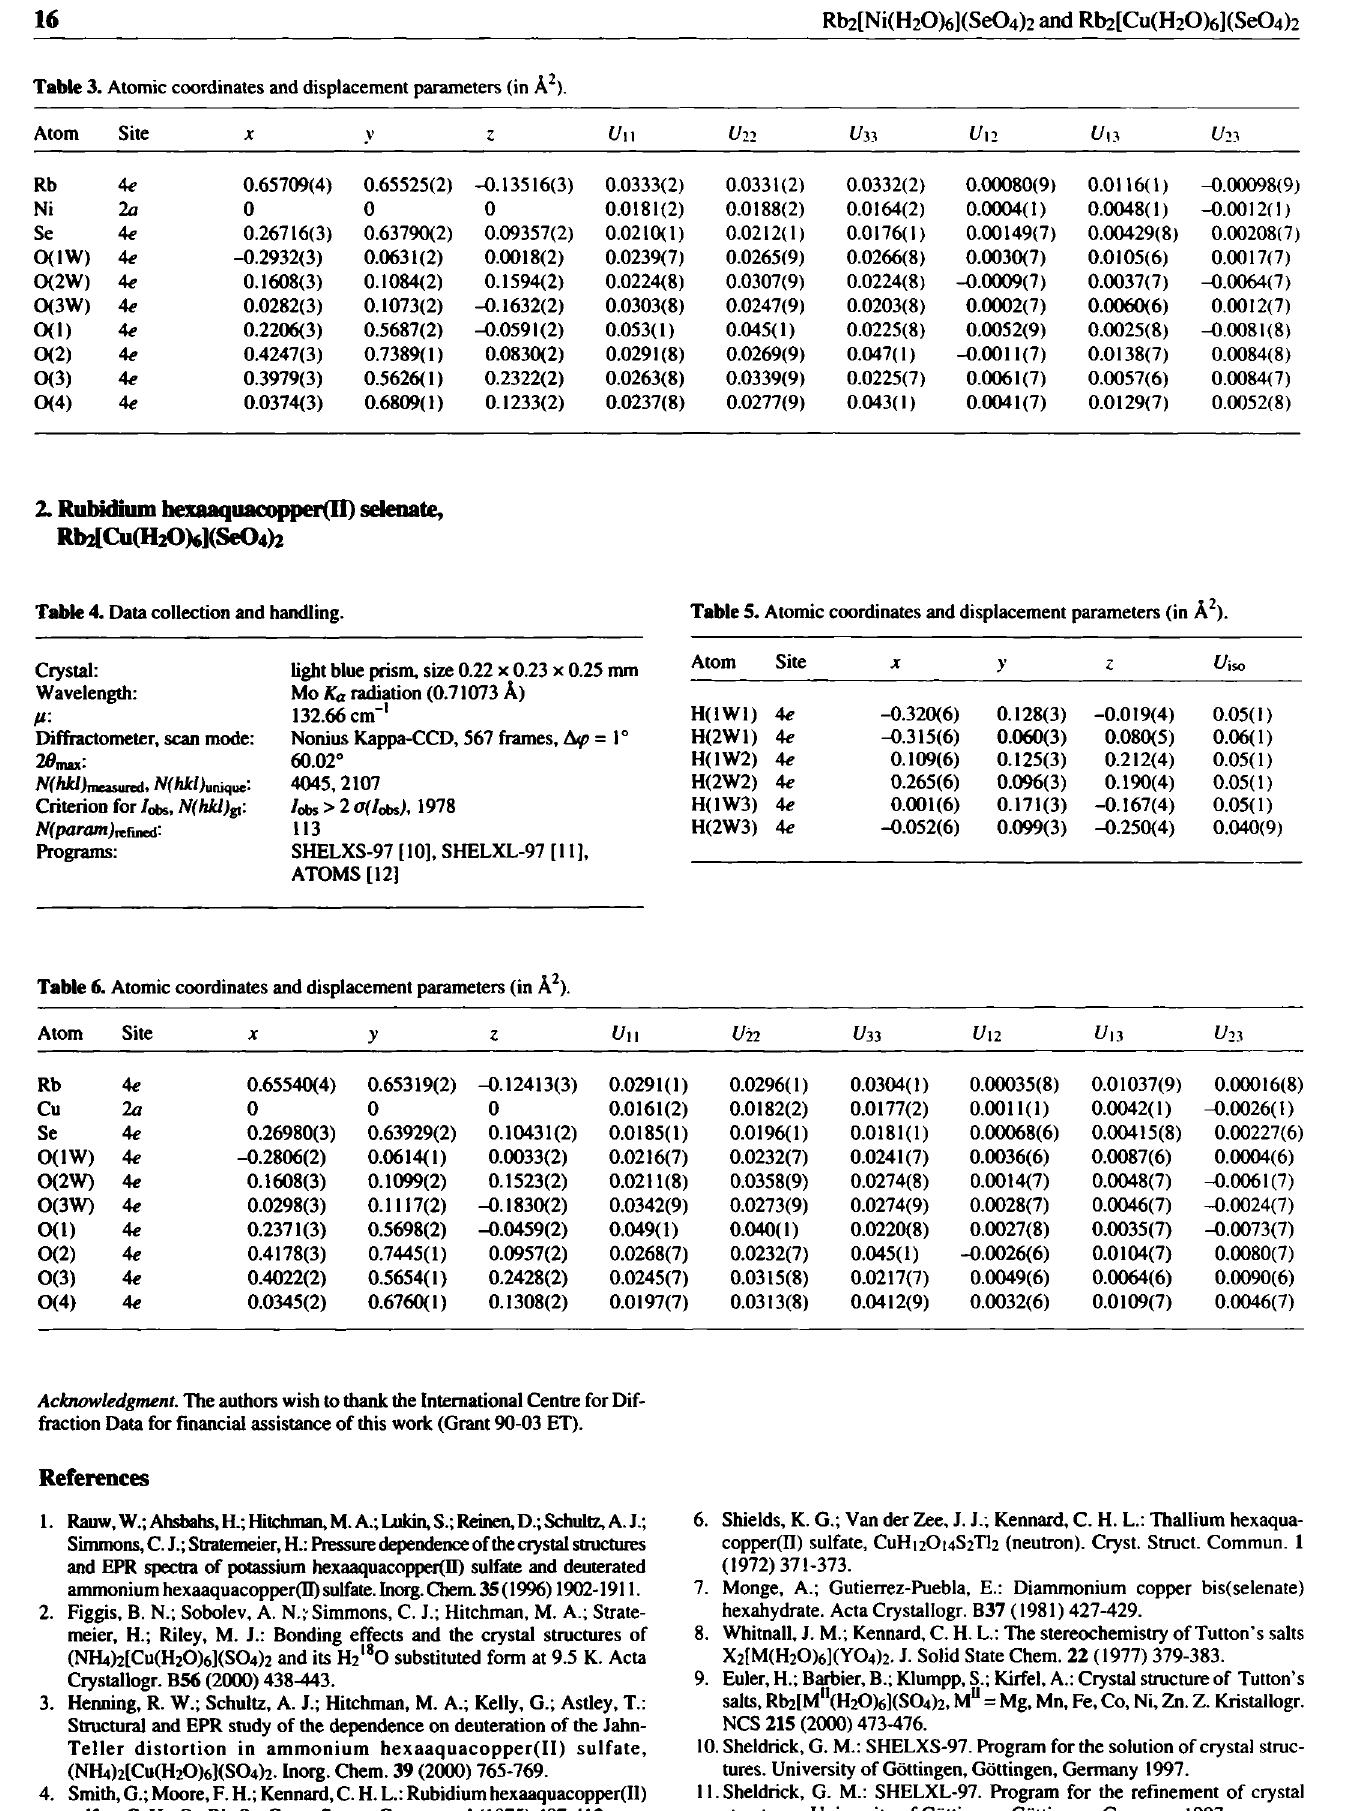
Table 3. Atomic coordinates and displacement parameters (in À 2 ).